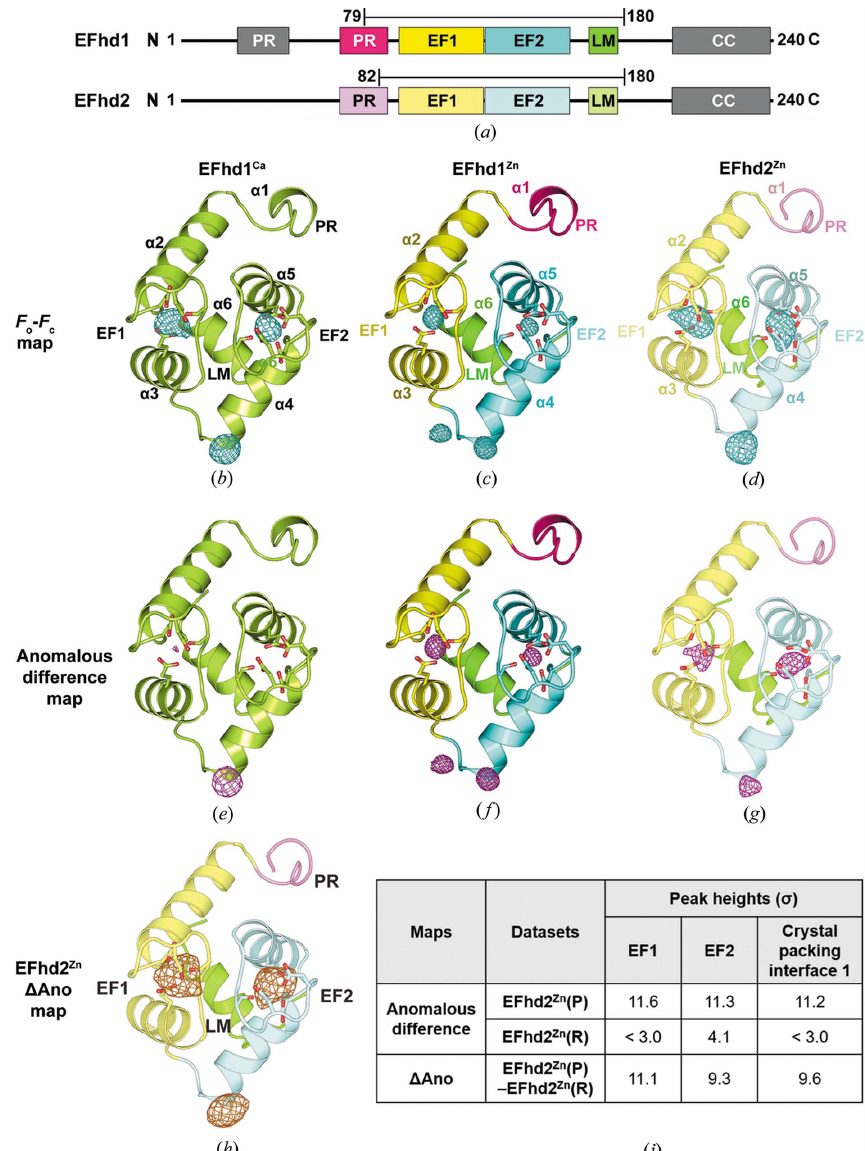
Figure 1 Analysis of (cid:5) A -weighted m F o (cid:4) D F c , anomalous difference and the difference between anomalous difference maps in EFhd1 or EFhd2. ( a ) Schematic of mouse EFhd1 and human EFhd2. Each is composed of a PR (proline-rich) region, EF-hand 1 (EF1), EF-hand 2 (EF2), LM (ligand mimic) helix and CC (coiled-coil) region. Upper bars indicate the crystallized regions of EFhd1 Ca , EFhd1 Zn (residues, 79–180) and EFhd2 Zn (residues, 82–180). ( b ), ( c ), ( e ) and ( f ) Overall structure of EFhd1 Ca and EFhd1 Zn . The EFhd1 Ca is shown in lime green. The EFhd1 Zn are shown in magenta, yellow, cyan or green. (cid:2) 1–6 indicates alpha helices 1–6. (cid:5) A -weighted mF o (cid:4) DF c ( F o (cid:4) F c ) and anomalous difference maps are shown in cyan and magenta, respectively. ( d ) and ( g ) Overall structure of EFhd2 Zn . The EFhd2 Zn are shown in magenta, yellow, cyan or green. The F o (cid:4) F c and anomalous difference maps are shown in cyan and magenta, respectively. ( h ) Difference between anomalous difference maps ( (cid:2) Ano) calculated from the EFhd2 Zn (P) and EFhd2 Zn (R) datasets. The (cid:2) Ano map was represented in the EFhd2 structure and shown in gold. ( i ) Table showing the peak heights ( (cid:5) ) of anomalous difference and (cid:2) Ano maps calculated from the EFhd2 Zn (P) and EFhd2 Zn (R) datasets. All maps are contoured at 3.0 (cid:5)